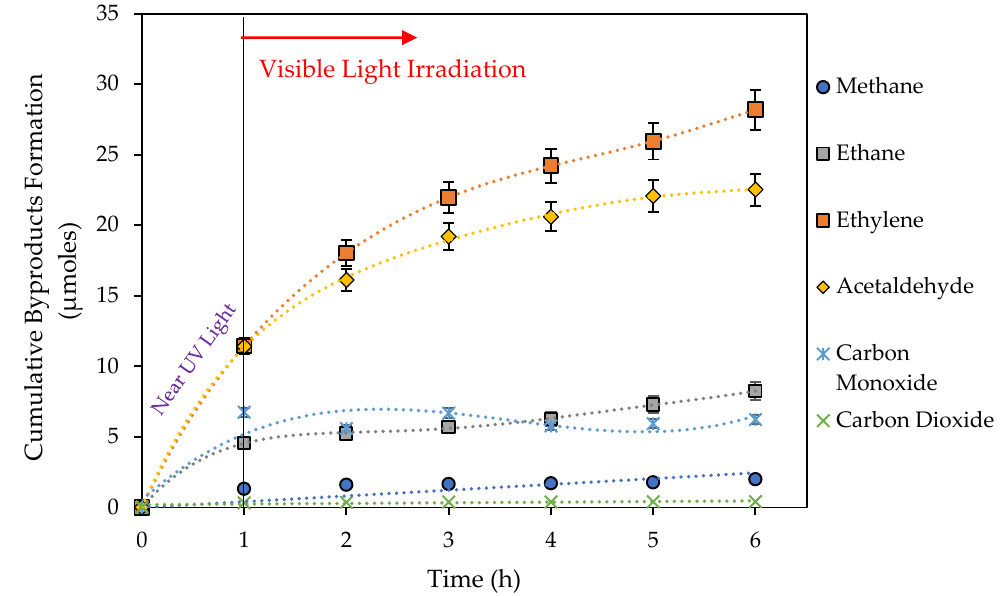
Figure 5. Cumulative amounts of carbon dioxide (CO 2 ), methane (CH 4 ), acetaldehyde (C 2 H 4 O), ethane (C 2 H 6 ), and ethylene (C 2 H 4 ) Obtained using a 0.25 wt% Pd-TiO 2 -VIS. Conditions: combined near-UV irradiation (1h) and visible light irradiation (5 h), photocatalyst concentration of 0.15 g/L, 2.0 v/v % ethanol, and argon atmosphere.